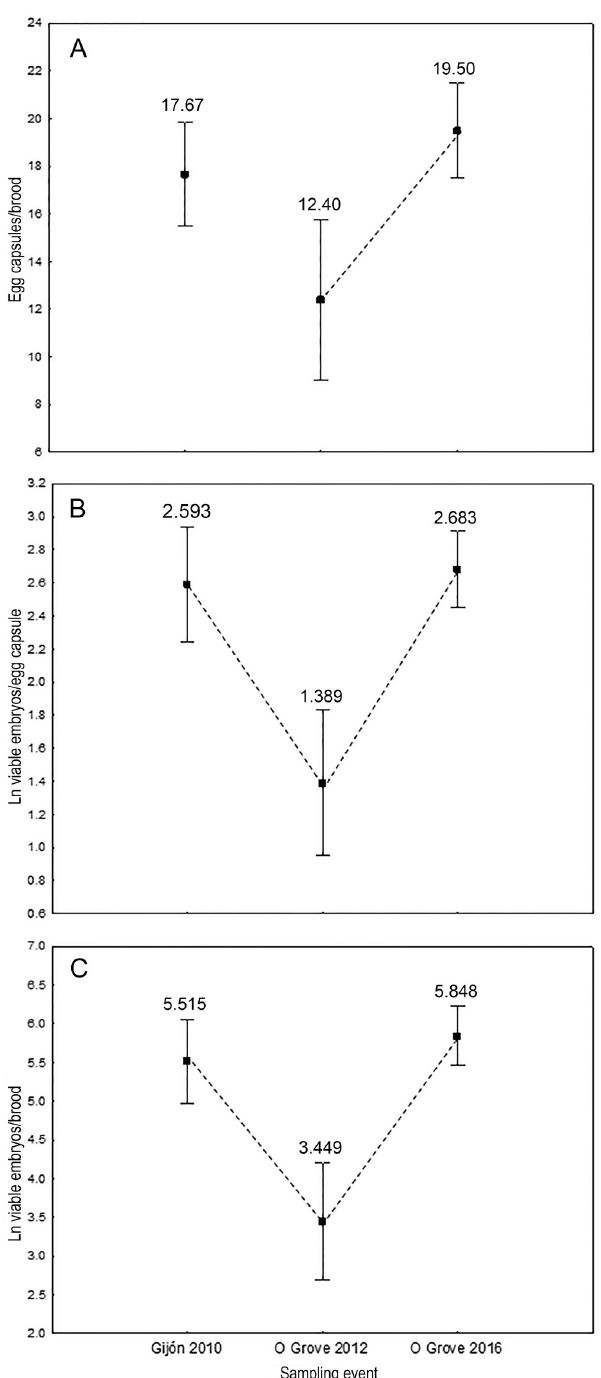
Fig 7. Comparison of the reproductive output among sampling events. Differences among samples in (A) the number of egg capsules per brood, (B) the number of viable embryos per brood (log-transformed) and (C) in the total number of viable embryos per brood (log-transformed) produced by females when controlling for female size. Vertical bars represent 95% confidence intervals. The small squares inside the box represent the unweighted means. Numbers above bars represent unweighted means. Discontinuous connecting lines among pairs denote significant differences at P < 0.05 (A) and at P < 0.01 (B, C) according to the unequal N HSD test.